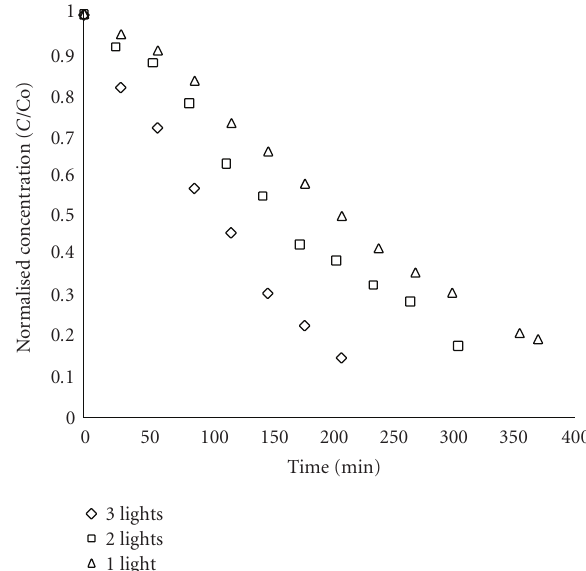
Figure 9: E ff ect of illumination profile on phenol degradation (28fin drum).